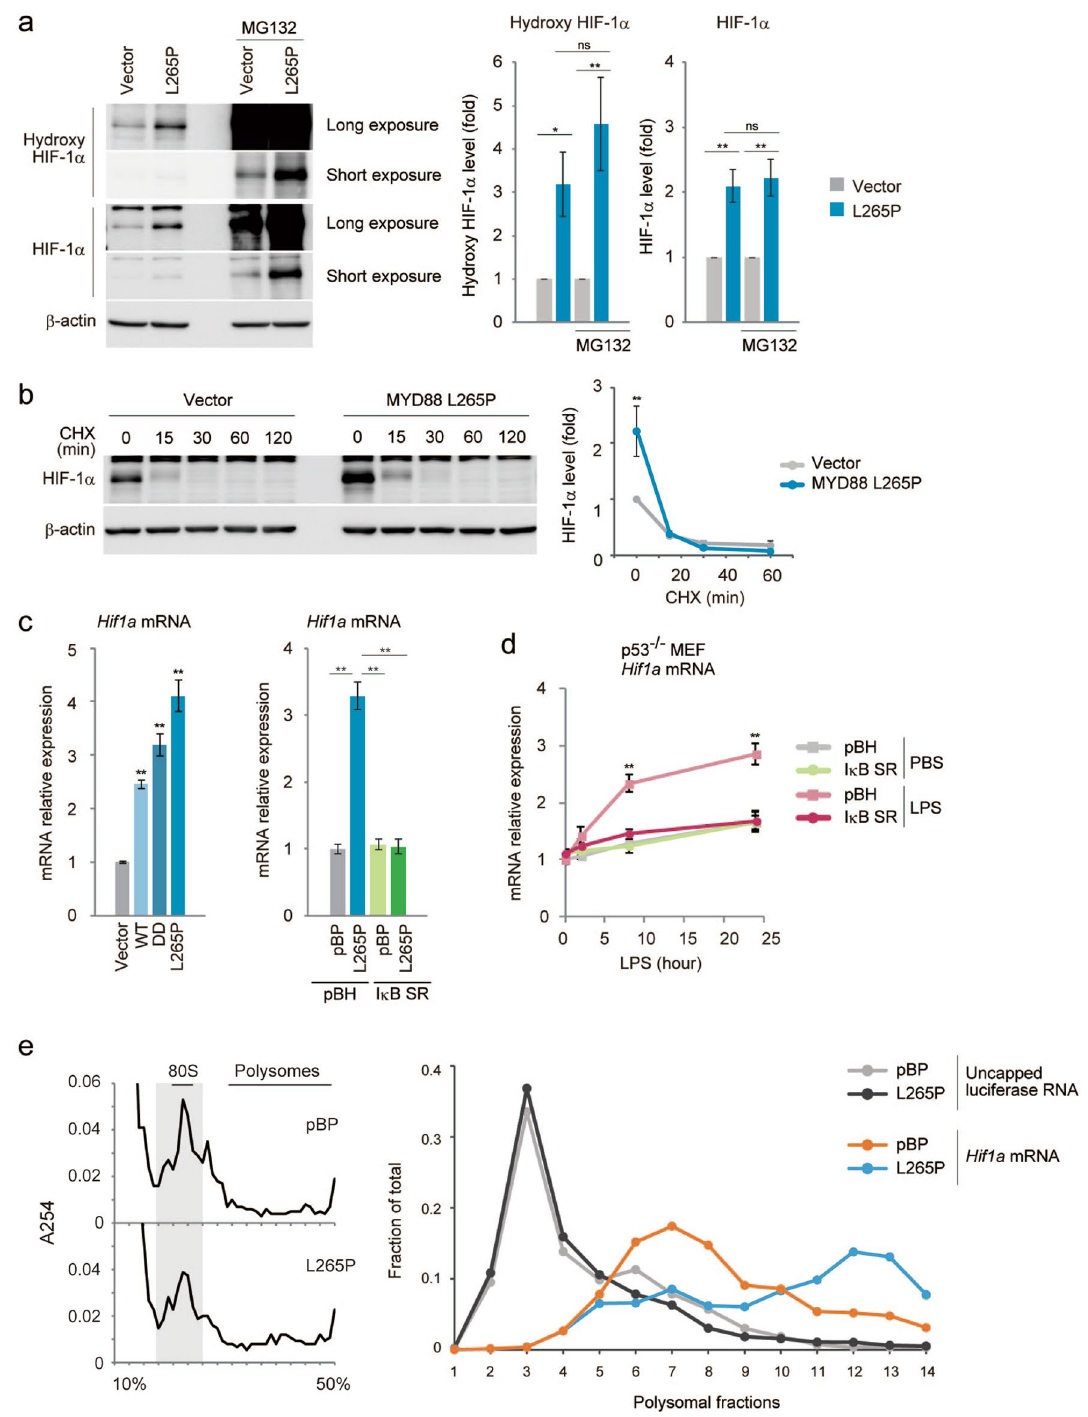
Figure 4. Increased glucose metabolism is mediated by HIF-1α expression regulated at the transcription and translation level in MYD88-expressing p53 −/− MEFs. ( a ) p53 −/− MEFs expressing vector or MYD88 L265P were treated with 40 μM MG132 for 7 h. Total cell lysates were analysed by immunoblotting (left). Protein expression was quantitated using ImageJ software and the respective protein blots are shown in the graph (right). ( b ) p53 −/− MEFs expressing vector or MYD88 L265P were treated with 100 μg/ml cycloheximide (CHX) for the indicated times. Total cell lysates were analysed by immunoblotting (left) and the quantification of HIF-1α signals is shown (right). ( c ) Hif1a mRNA expression was quantified in the indicated cells by qPCR. ( d ) p53 −/− MEFs were stimulated with 100 ng/ml LPS for 2, 8, and 24 h. Expression of Hif1a mRNA was quantified by qPCR. ( e ) Polysomal fractionation was performed for p53 −/− MEF expressing vector or MYD88 L265P to detect Hif1a mRNA translation efficiency. The sucrose gradient was 10–50% and 15 fractions were collected. The OD254 plot for each polysome profiling experiment (left). The relative distribution of Hif1a mRNA associated with each fraction of the gradient was analysed by qPCR (right). The uncapped luciferase RNA was added as an exogenous control, which was not associated with ribosomes and remained in the top fraction. ( c , d ) The y-axis values are relative fold change for gene transcripts normalised to β-actin. Data represent the mean ± s.d. (n = 3). ( a – d ) The data represent the mean ± s.d. using one-way ANOVA followed by Scheffe’s F test. *P < 0.05, **P <